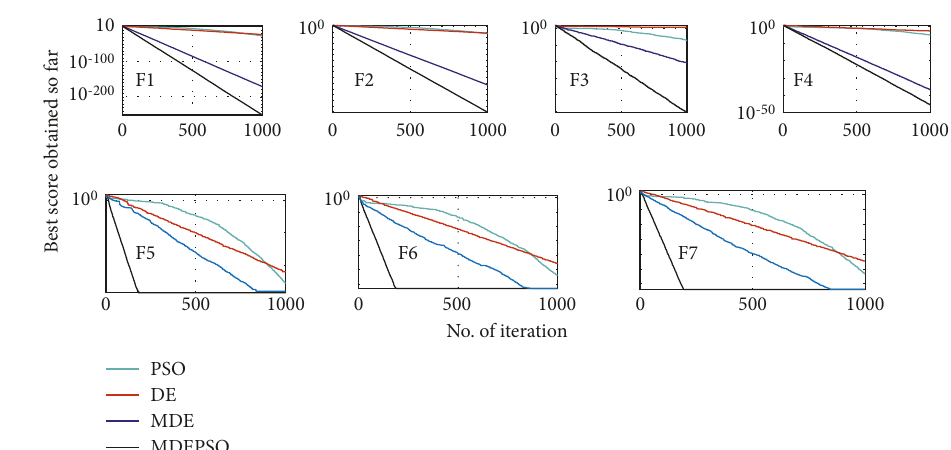
Figure 8: Representation of minimizations with benchmarks.